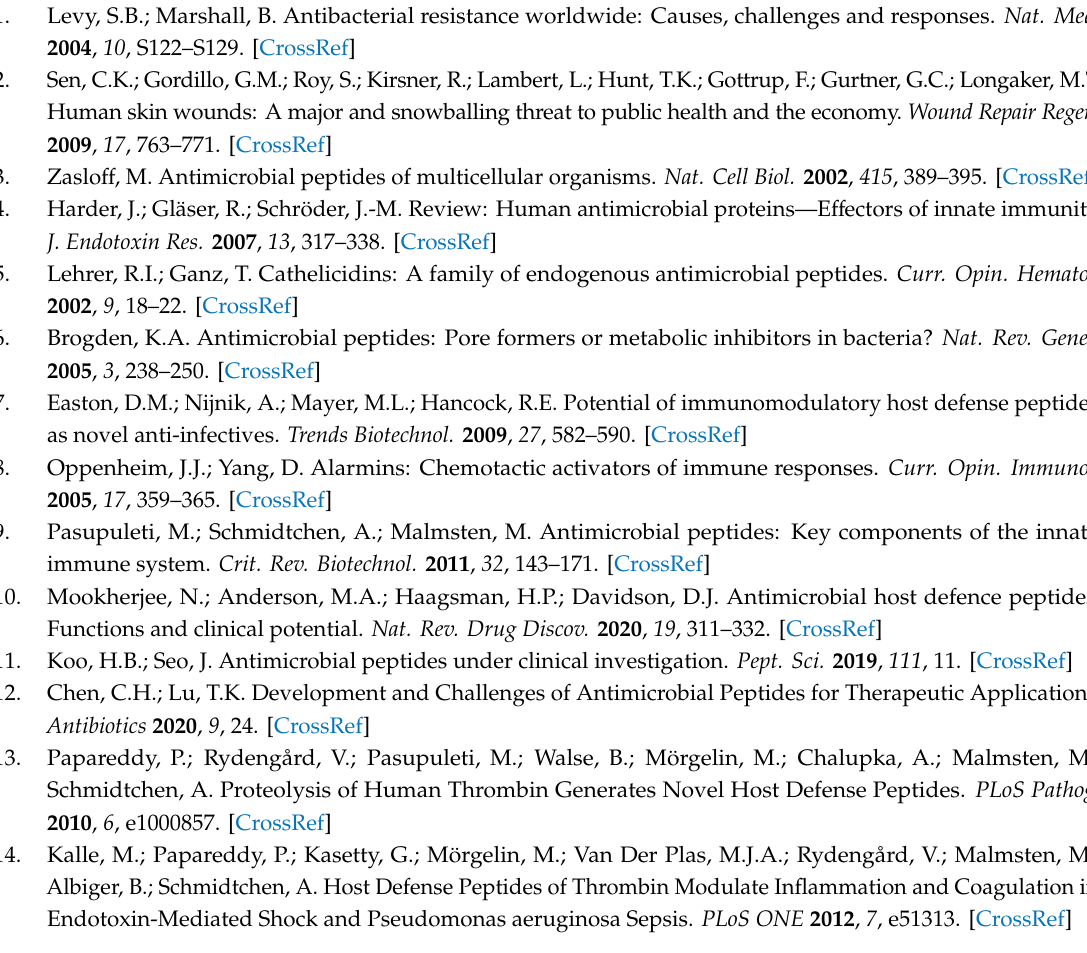
Figure S1: E ff ect of pH on TCP-25 oligomerization, Figure S2: Thermal and chemical denaturation of TCP-25 at low concentration, Figure S3: Reversibility of thermal denaturation of TCP-25 at pH 5, Figure S4: E ff ect of pH and temperature on oligomerization of TCP-25, Figure S5: HVF18 NMR structure oligomerization interface, Figure